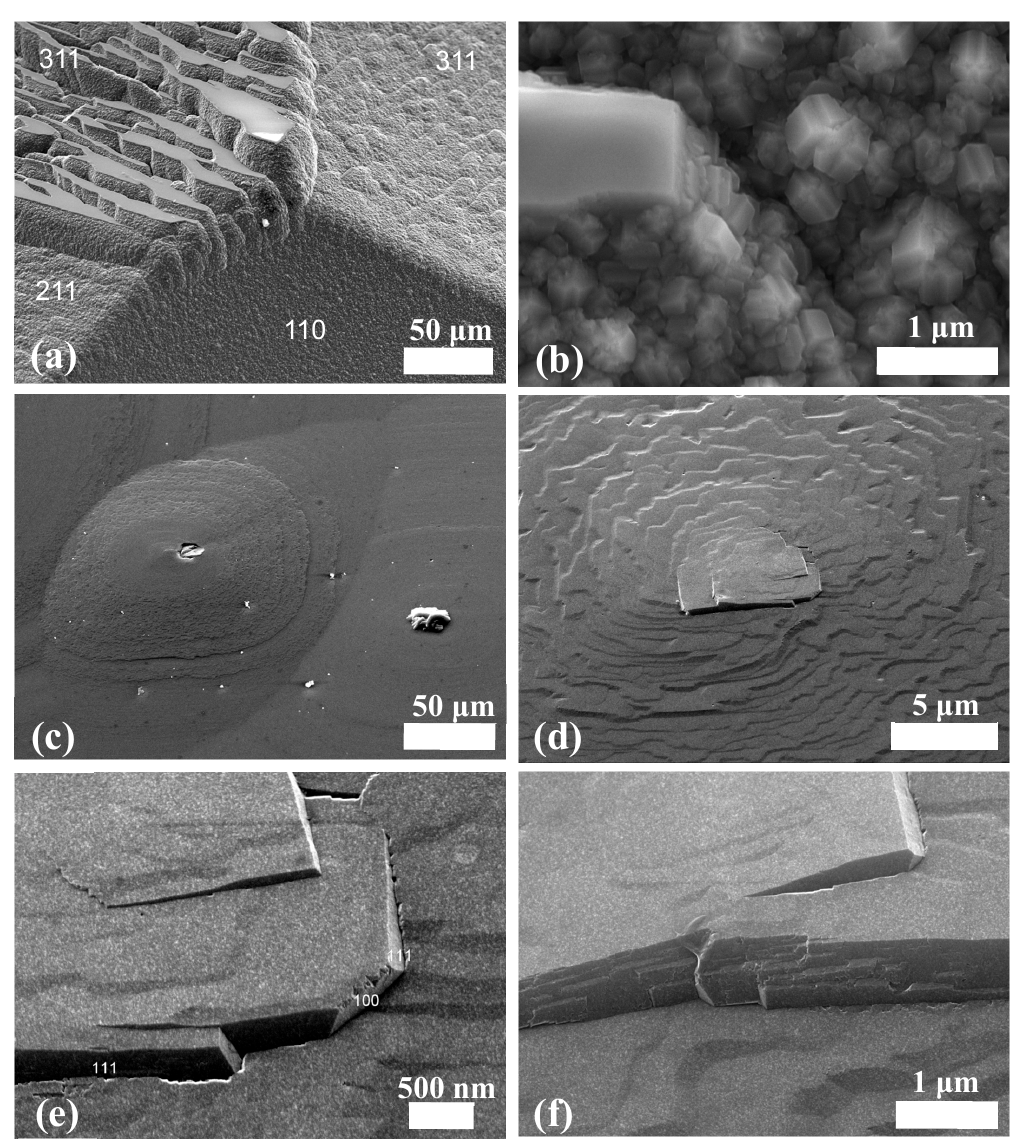
Figure 3. SEM images after 70-min growth on a single-crystal HPHT substrate: ( a ) the bevel of the substrate with indicated crystallographic faces; ( b ) {311} face at higher magnification; ( c ) stepped growth and formation of a hillock on the {100} face; ( d ) generation of a polycrystalline aggregate on the top of a hillock on the {100} face; ( e ) the same hillock, formation of low-index crystalline faces on edges of thick growth steps; ( f ) on the top of another hillock, a relief is developed on the edges of thick growth step.